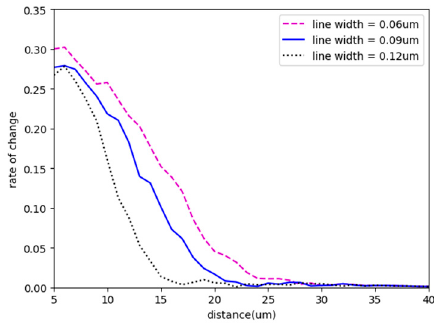
Figure 12. The effective planarization length test with 0.45 um gate spacing. Table 1. The average minimum (cid:1856) (cid:3036) , which keeps the rate of change of the dishing defect (cid:1830) (cid:3036) within 5%. Average Minimum (cid:2186) (cid:2191) Line Width 0.06 um Line Width 0.09 um